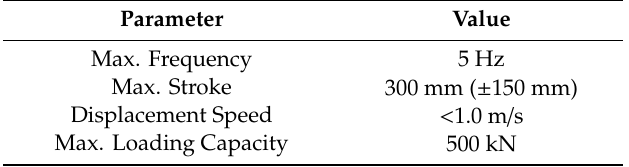
Table 4. Characteristics of the HIFI-J actuator.